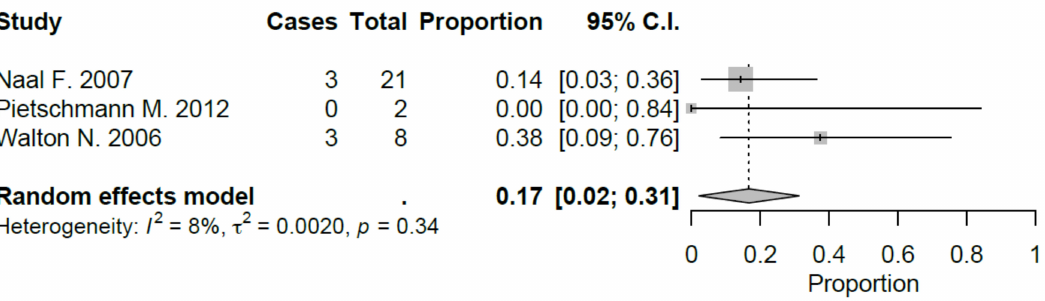
Figure 7. Return to fitness after UKA (C.I.: Confidence Intervals).